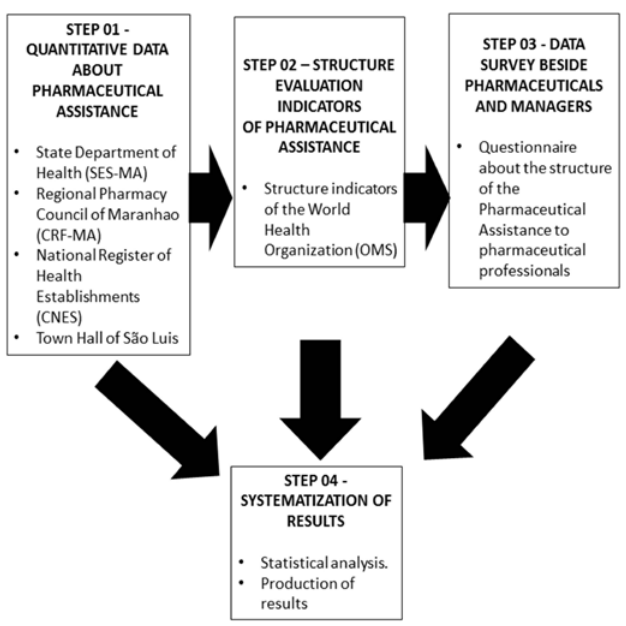
FIGURE 1 - Flowchart of methodological steps for